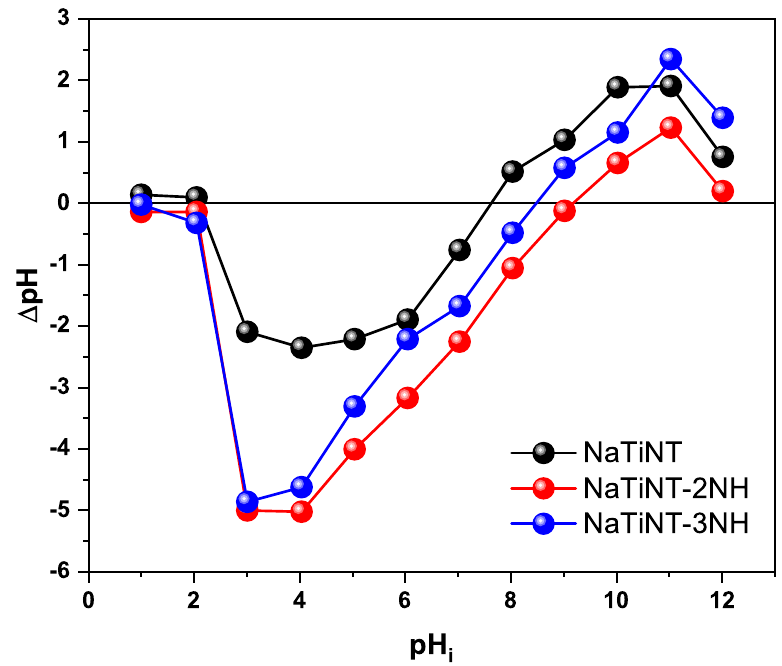
Figure 6. pH pcz of the NaTiNT, NaTiNT − 2NH, and NaTiNT − 3NH